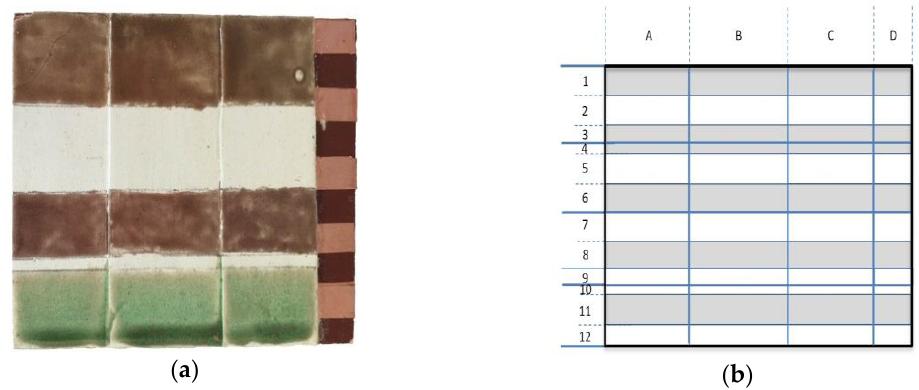
Figure 2. ( a ) Multi-layered sample (75 × 52 mm); ( b ) schematization of the different areas analyzed. In grey are indicated the areas containing the metal layer (copper tape). Lines 1, 2, 3 are varnished with Colophony (Col-Eth); lines 4, 5, 6, 10 are not varnished; lines 7, 8 are varnished with Shellac (She-Eth); lines 10, 11, 12 are varnished with Sandrac (Oil-San); Column A contains a very fine gypsum layer (Gy1); column B has a thick Gy1 layer; and column C contains the thickest Gy1 layer.